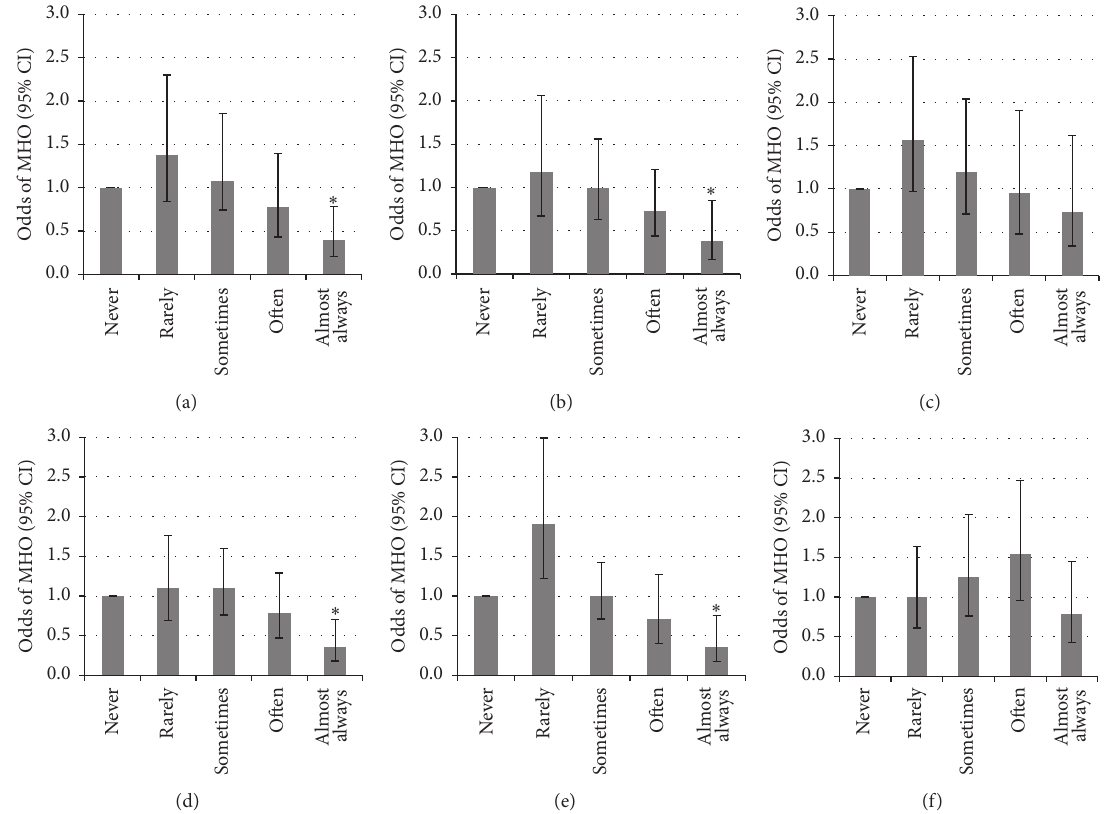
Figure 2: The odds of metabolically healthy obesity for each sleep quality question. (a) “How often did you have trouble falling asleep?”; (b) “How often did you wake up during the night and had trouble getting back to sleep?”; (c) “How often did you wake up too early in the morning and were unable to get back to sleep?”; (d) “How often did you feel unrested during the day, no matter how many hours of sleep you have had?”; (e) “How often did you feel excessively or overly sleepy during the day?”; and (f) “How often did you not get enough sleep?” Modeled for MHO (i.e., absence of metabolic syndrome according to the Joint Interim Statement, ≤ 2 cardiometabolic dysfunctions) adjusting for age, sex, ethnicity, education, income, smoking, alcohol, leisure-time physical activity, and physician diagnosed sleep disorder. Responses for each question were as follows: never; rarely (1 time a month); sometimes (2–4 times a month); often (5–15 times a month); and 4, almost always (16–30 times a month). MHO is metabolically healthy obesity in people with BMI of ≥ 30 kg/m 2 . ∗ Significant